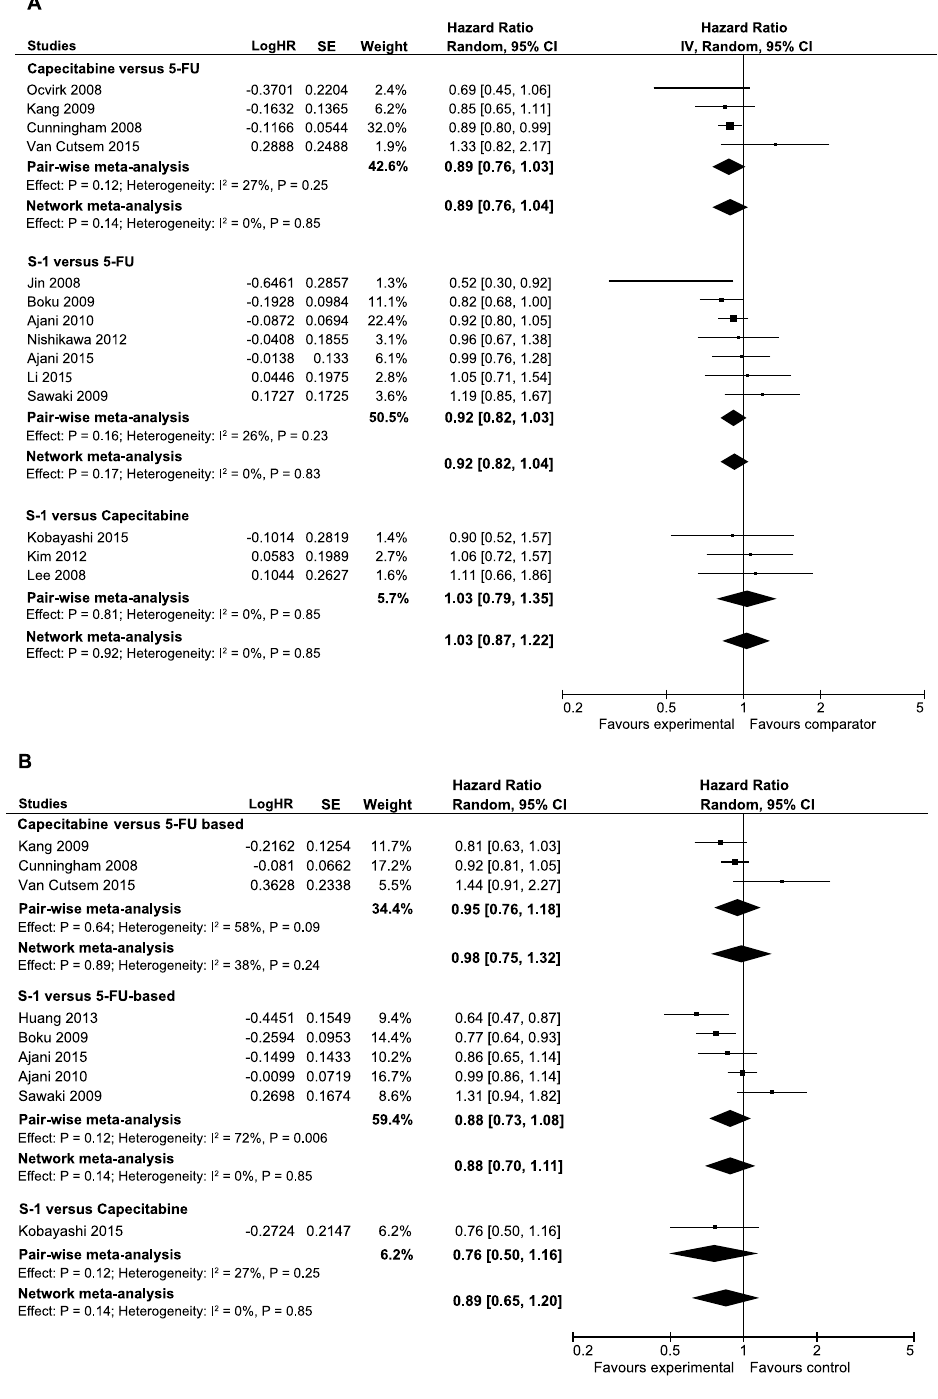
Figure 3. Results of the network meta-analysis for capecitabine, 5-FU and S-1 based regimens. ( A ) Forest plot of network meta-analysis for overall survival. ( B ) Forest plot for progression free survival. The lower pooled effect-size represents the combined hazard ratio and 95% Credible Intervals (95%CrI) derived from network- meta analysis. Abbreviations: 5-FU: